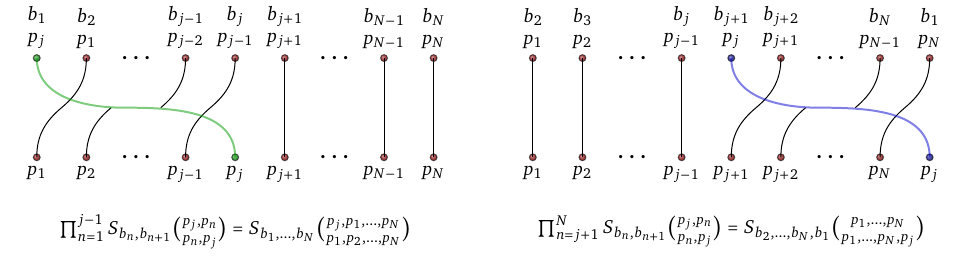
Figure 3: Factorisation of the scattering processes that enter Eq. (72). The chosen permutation is π ∶ ( j , 1, . . . , N ) ↦ ( 1, 2, . . . , N ) . The dots represent particles of types b 1 , . . . , b N , to which momenta are assigned. The lines connecting them represent the exchange of momenta during collisions. Each crossing of two lines contributes a two-particle scattering matrix to the product that, at the end, represents the entire scattering